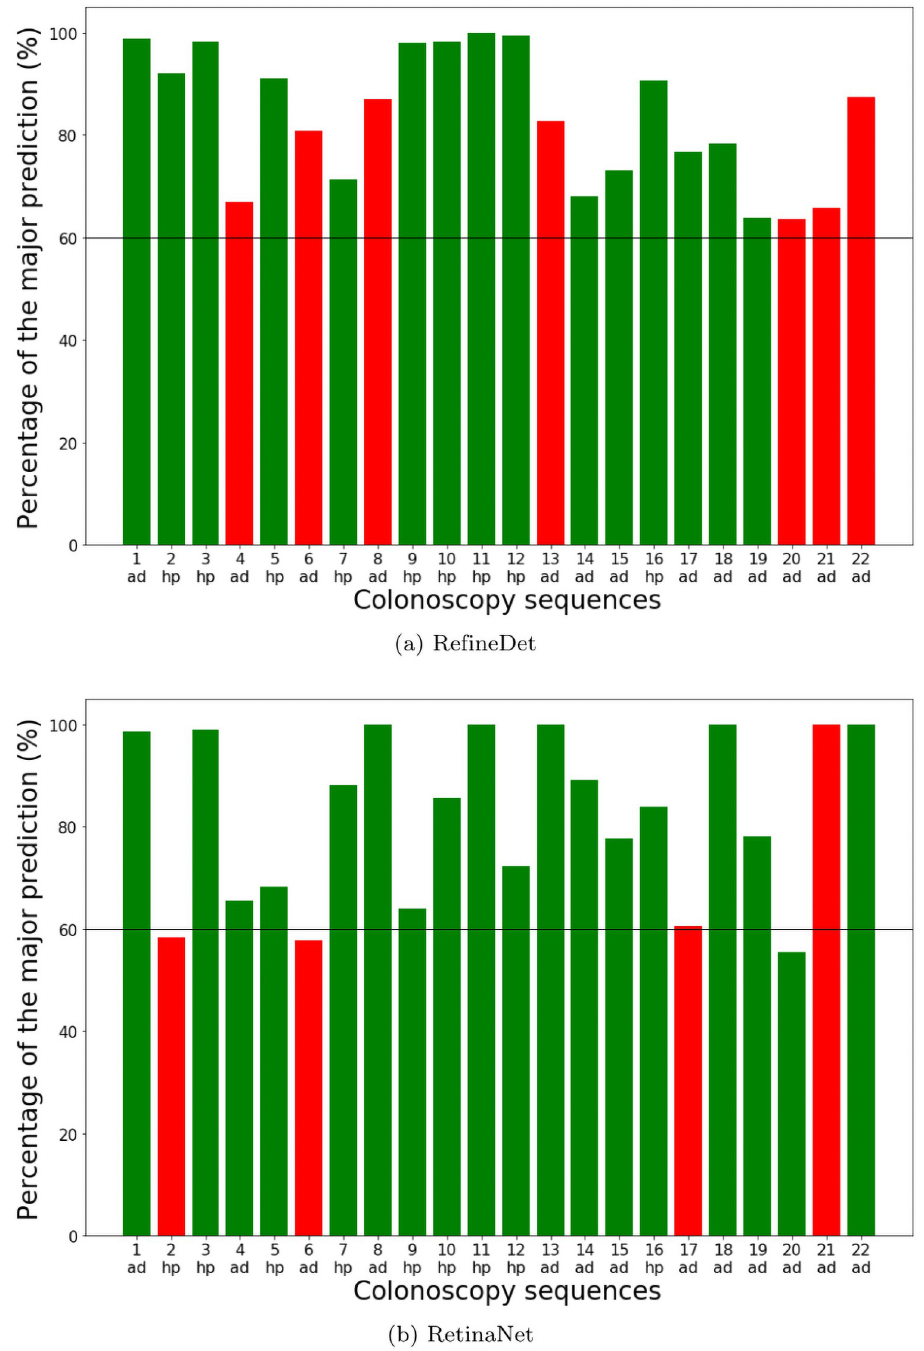
Fig 11. Percentage of the dominant class. Detectors predict the polyp category in each individual frame. The category with more than 50% of all frames is the dominant category for that video sequence. The charts show the percentage of frames classified as the dominant class in each test sequence. (ad) and (hp) on the bottom means ground truth class adenomatous and hyperplastic respectively. Correct predictions are in green and misclassifications are in red.